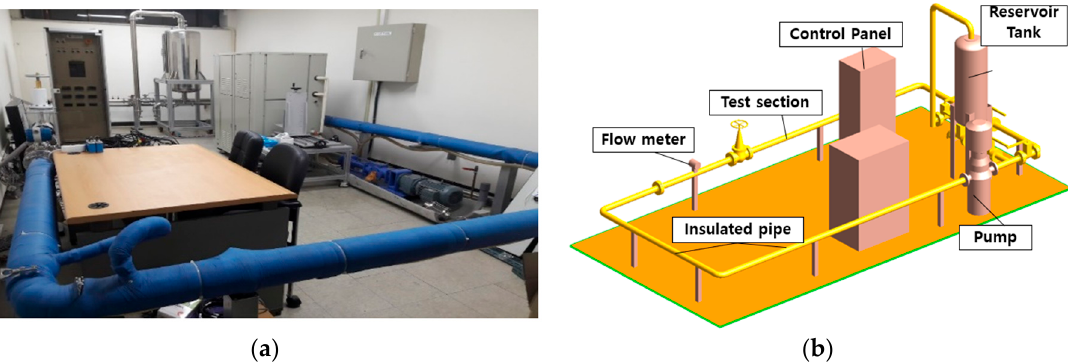
Figure 1. Two-phase (air-water) flow loop in Pusan National University: ( a ) flow loop facilities; ( b ) 3D model. Table 1. Specification of flow loop test facilities.